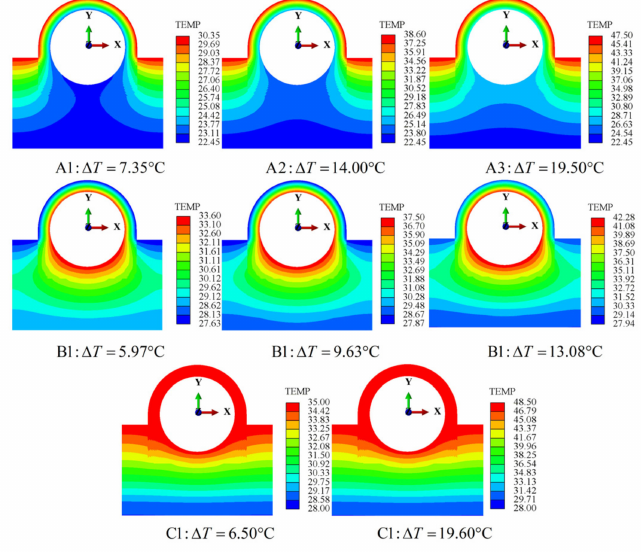
Figure 13. Temperature fields of the penstock exposed to different temperature